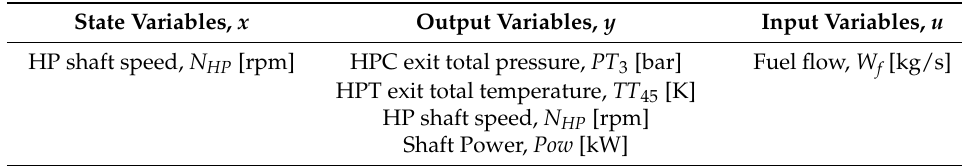
Table 4. State variables, control inputs and outputs of the desired engine. State Variables, x Output Variables, y Input Variables, u HP shaft speed, N HP